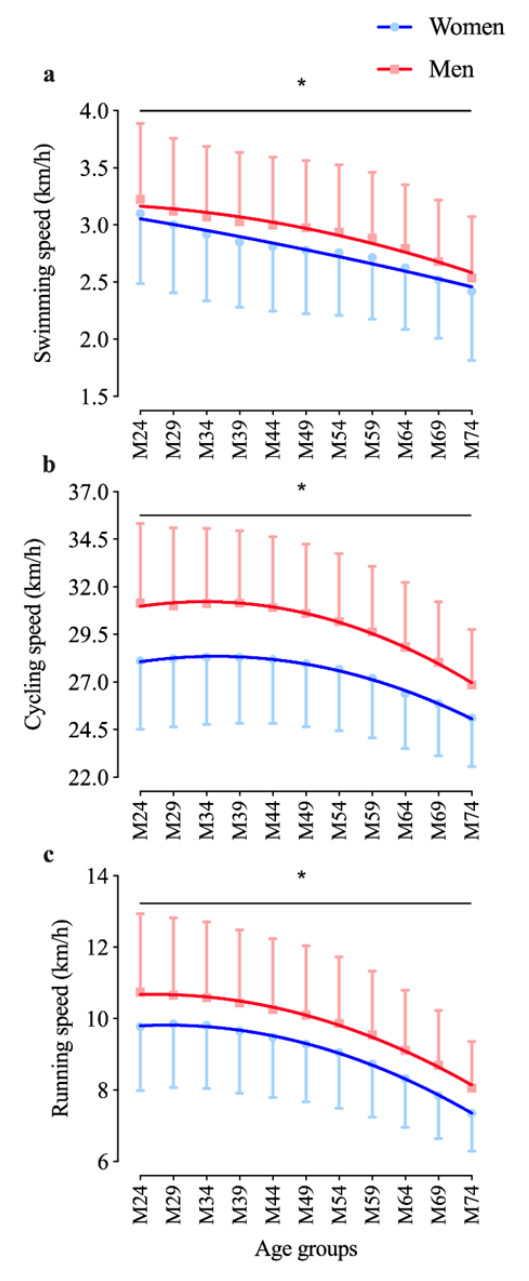
Figure 1. Age group-dependent decline in split discipline performance expressed in km/h; ( a , top): swimming speed; ( b , middle): cycling speed; and ( c , bottom): running speed; ( a – c ): men in red, women in blue. * Age group, sex, and interaction effect ( p < 0.05).